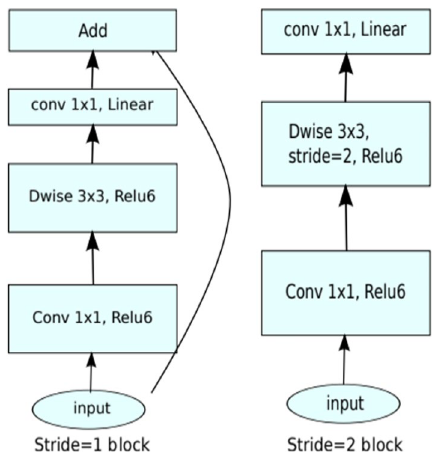
Fig. 2 MobileNet v2 architec- ture, obtained from